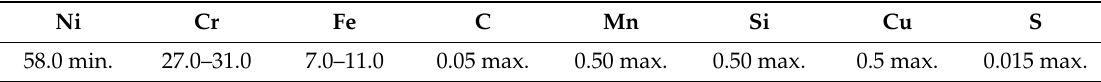
Table 1. Chemical compositions of Inconel 690 (wt